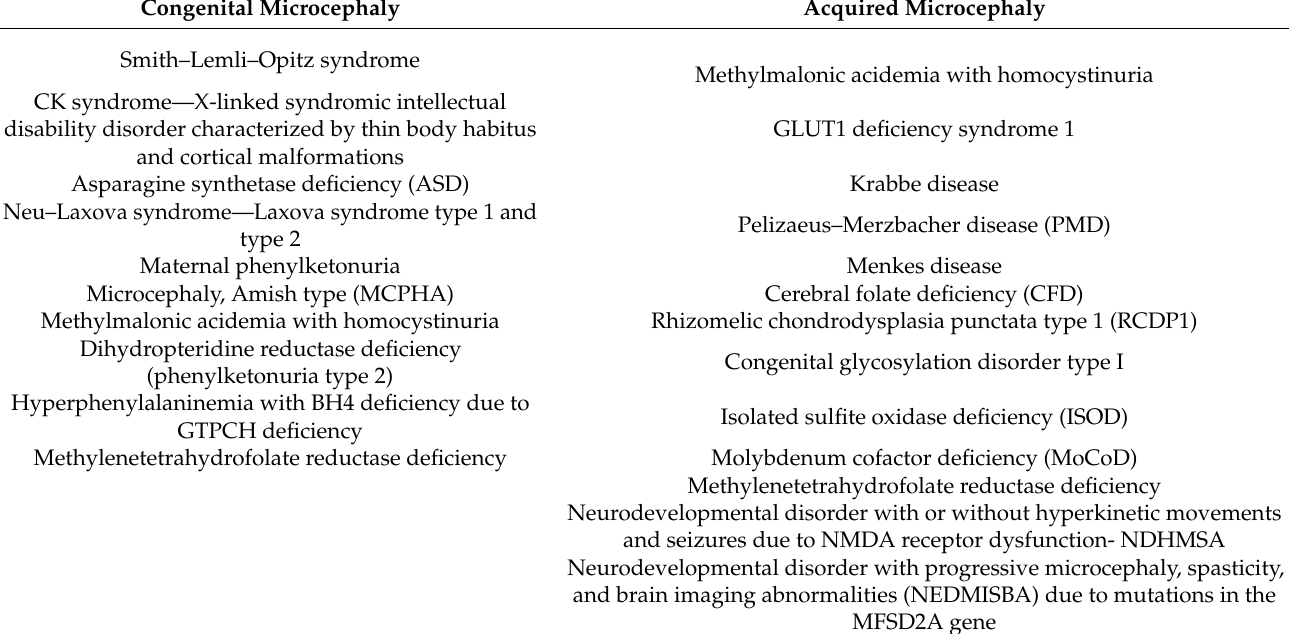
Table 1. The division of diseases into those with congenital and acquired